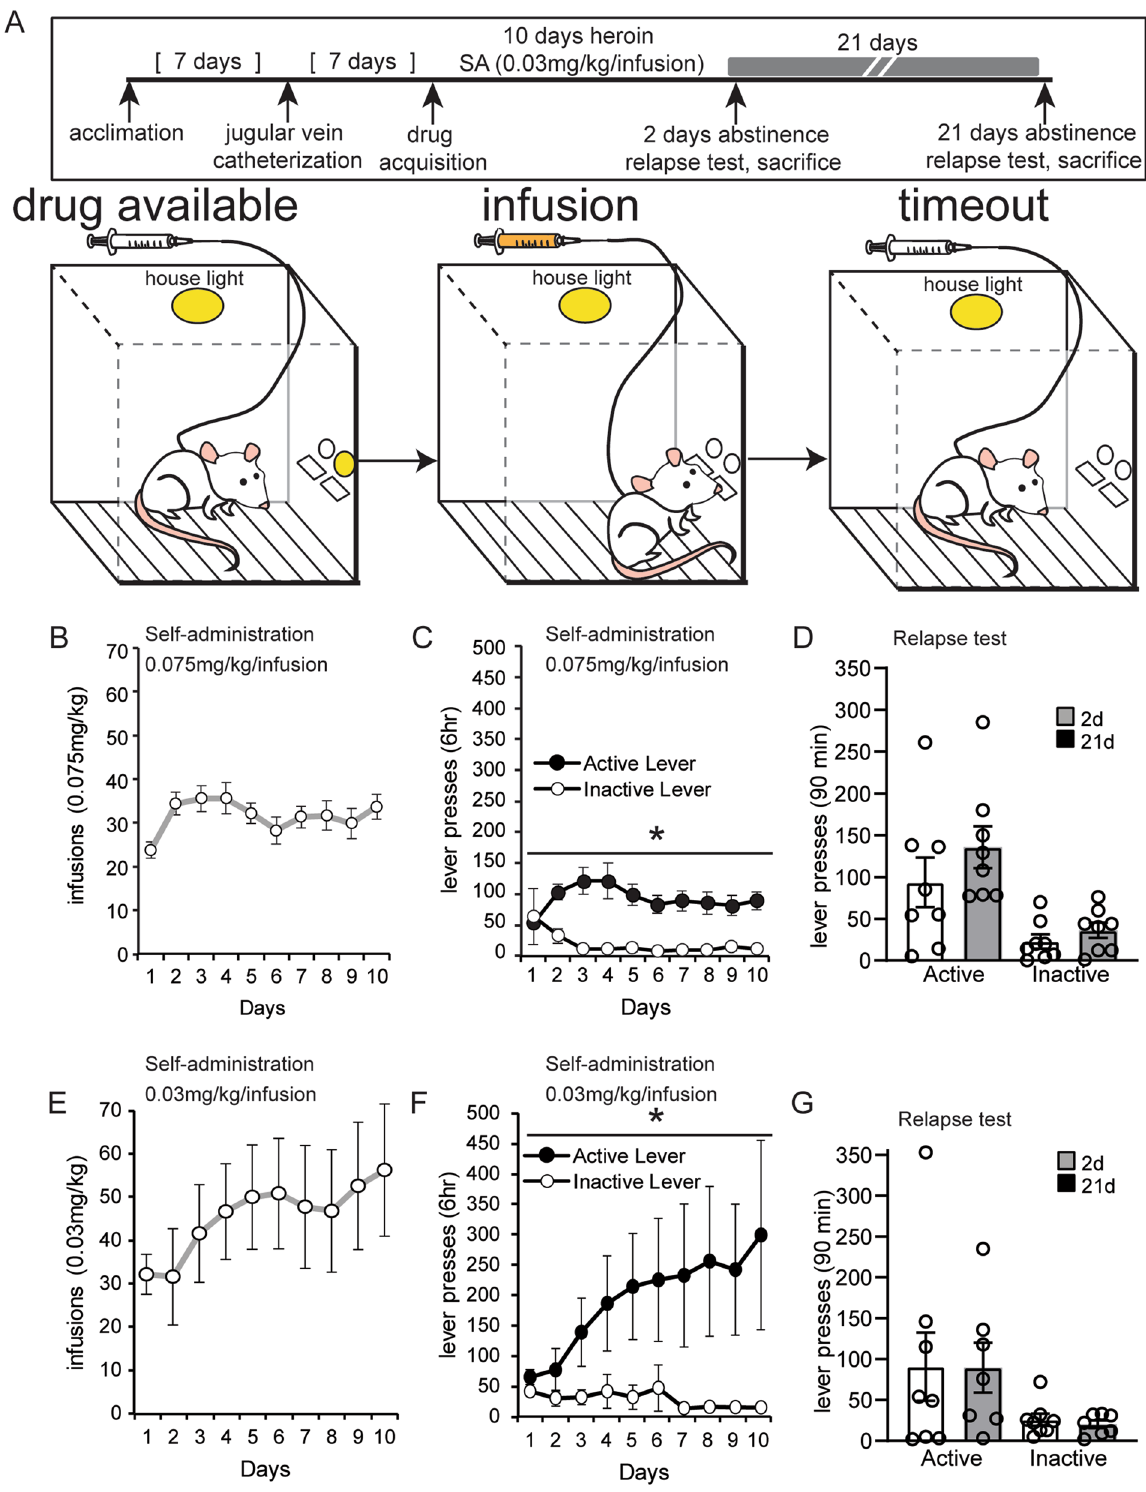
Figure 2. Discriminative cues produce steady drug-seeking during abstinence. ( A ) An overview of the protocol to measure drug seeking after abstinence from heroin self-administration using discriminative drug cues. Animals underwent an identical experimental protocol as described in Experiment 1 except with modified light and tone cues. ( B , C , E , F ) The number of infusions and lever presses during heroin self-administration at a 0.075 mg/kg/infusion dosage ( B , C ) and a lower 0.03 mg/kg/infusion dosage ( E , F ). ( D , G ) Lever pressing during the relapse test after forced abstinence from the 0.075 mg/kg/infusion dosage ( D ) and the 0.03 mg/kg/ infusion dosage ( G ). Error ± SEM. * p <